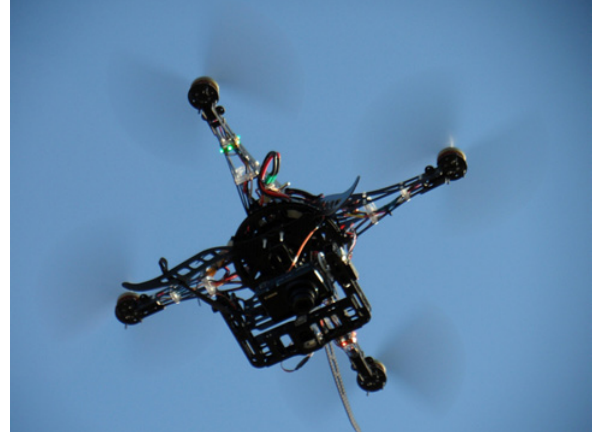
Figure 1: The quadrocopter flying with the camera ready.